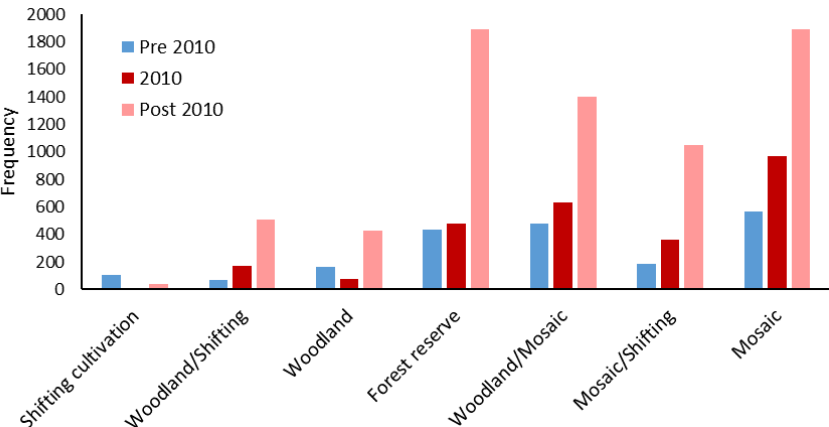
Figure 10. Land change dynamics against Global Forest Change deforestation data classified here as before 2010, in the year 2010, and after 2010.